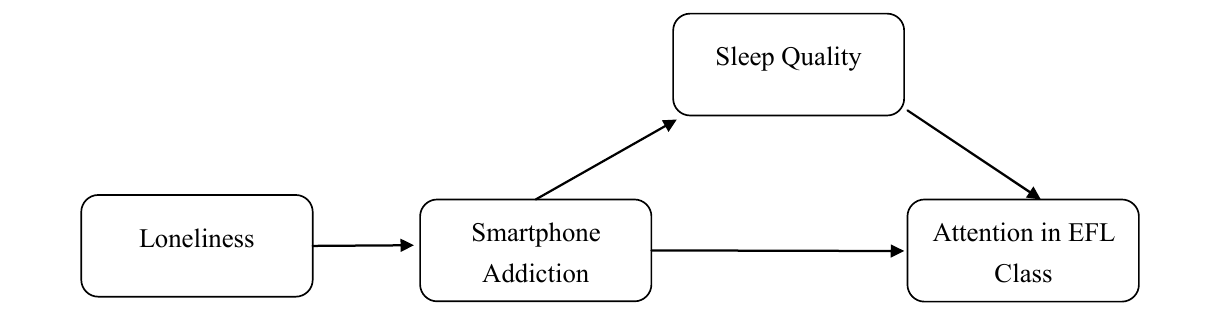
Figure 1. Conceptual framework.